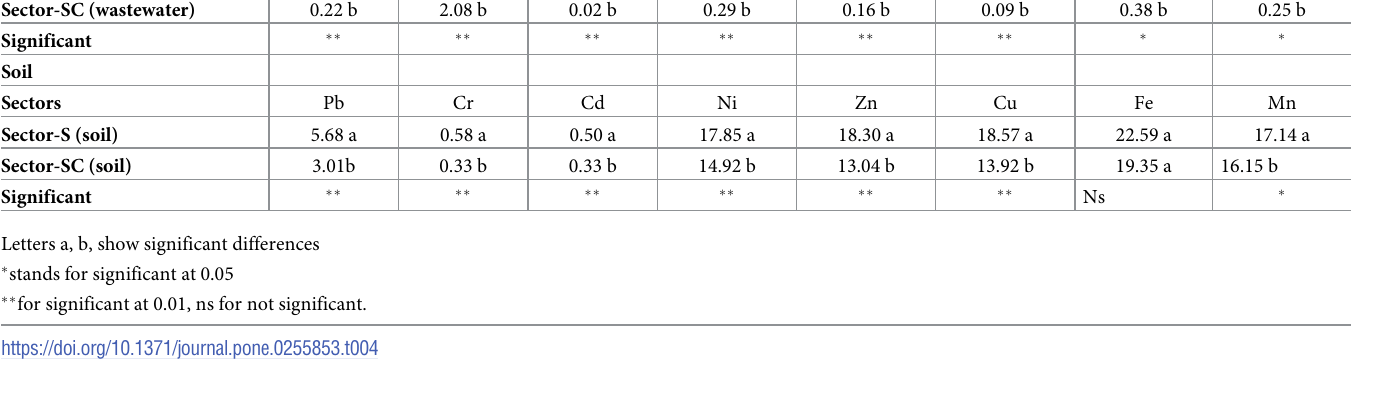
Table 4. ANOVA analysis for heavy metals in water and soil of two different sectors in Swabi. Water